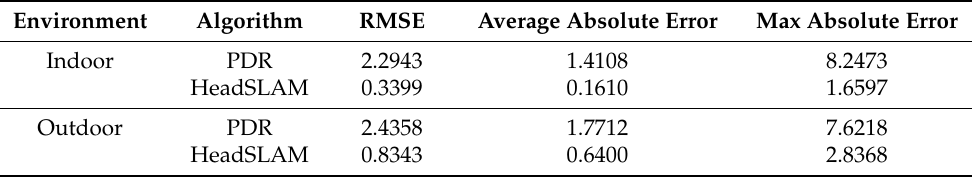
Table 2. Errors in meters (m) are given for the indoor and outdoor environments for both the PDR and HeadSLAM methods. RMSE is the Root-Mean-Squared Error. A significant difference based on the Wilcoxon signed-rank test ( p -value 1.63 · 10 − 11 ) was found for all six direct comparisons between the PDR and HeadSLAM